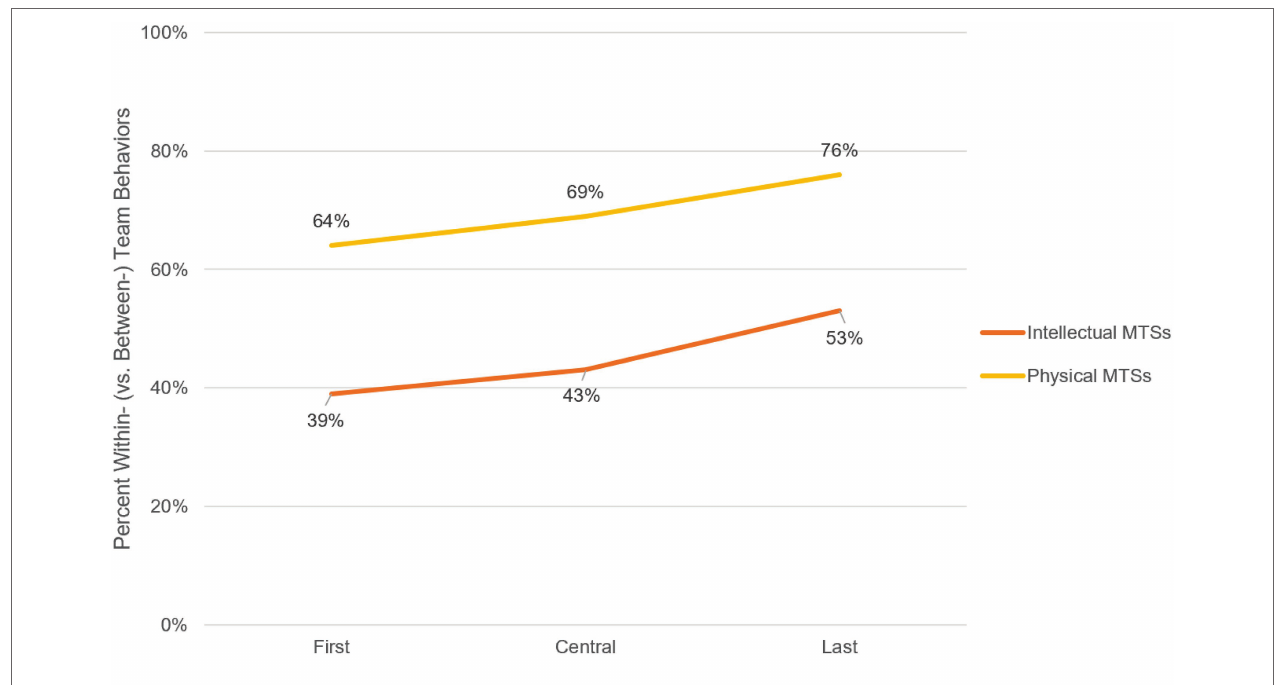
FIGURE 4 | Change in Within vs. Between Behaviors over the Action Phase of the Performance Episode by MTS Goal Type. This descriptive evidence presented in this figure and throughout this theme is based upon only cases of external physical MTSs ( n = 25), as the data set only includes cases of external intellectual MTSs ( n = 5) due to limited availability and accessibility of cases of internal MTSs; this is discussed further in the Limitations section. By removing the cases of internal physical MTSs ( n = 10) from this comparison, we aimed to mitigate confounding the effects of boundary status with those of goal type. The y-axis represents the percentage of within-team behaviors, relative to the percentage of between-team behaviors. The x-axis indicates the coded behaviors that occurred within each section of the performance episode. For example, the furthest right data point on the lower line indicates that, for all coded behaviors in the last third of the performance episode, for cases of performance for MTSs with intellectual goal types, the behaviors were 53%